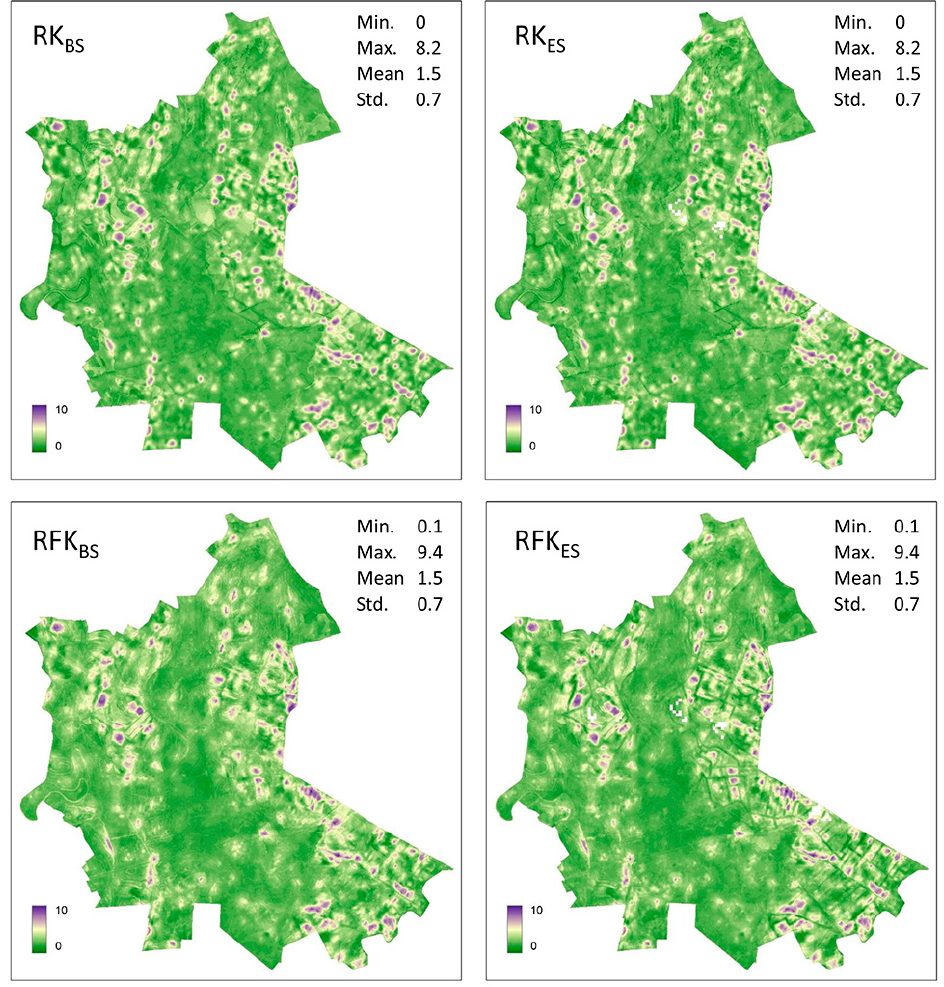
Figure 4. IEW indundation probability result maps of the two methods (RK – Regression Kriging, RFK – Regression Forest combined with Ordinary Kriging) by application of two co-variable packages (basic set (BS), extended set (ES)).